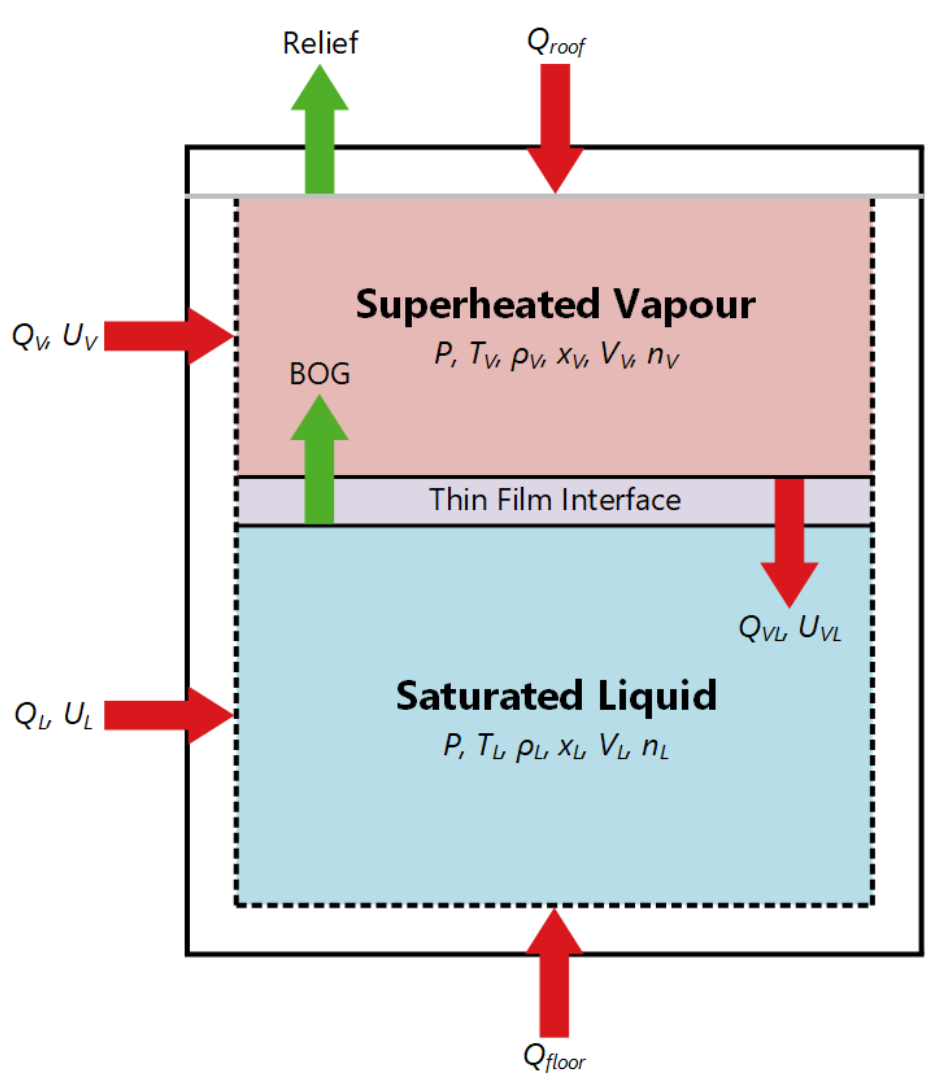
Figure 2. A conceptual schematic of the superheated vapor model implemented in BoilFAST, show ‐ ing the heat and mass transfer processes considered for a storage tank exchanging heat with the ambient